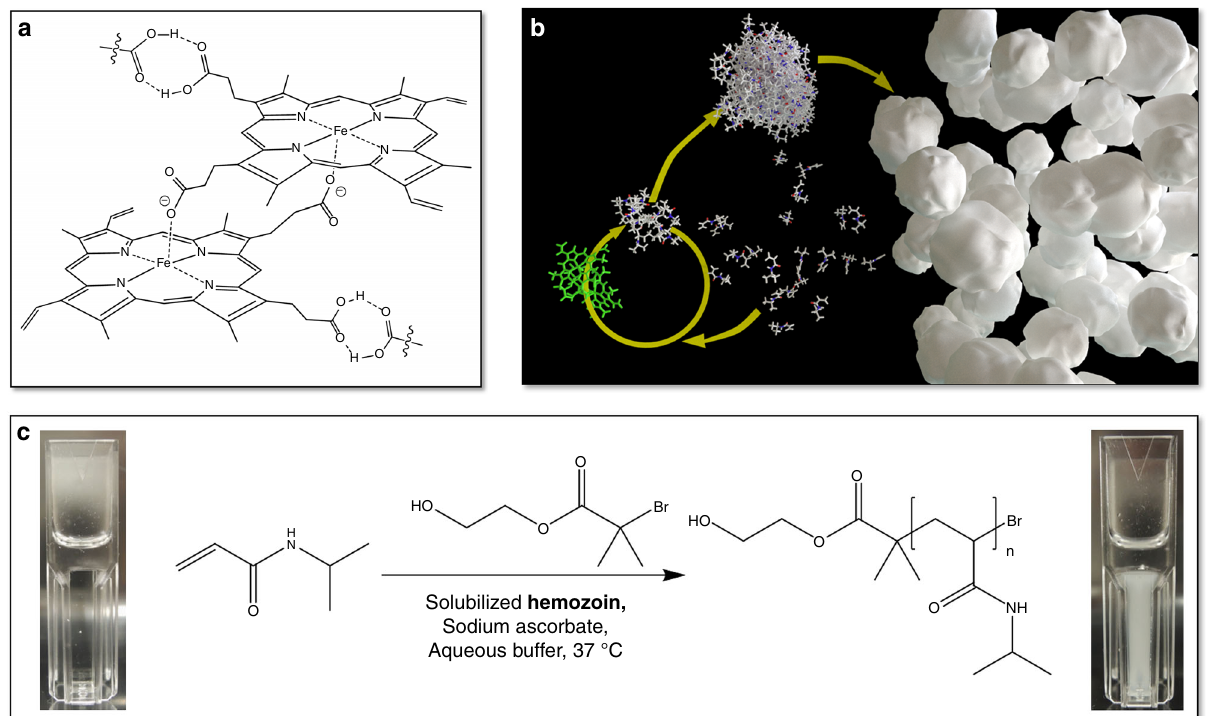
Fig. 1 Biocatalytic precipitation polymerization of NIPAAm as hemozoin assay. a Structure of Hz, a supramolecular crystal of dimers of hematin. b Schematic depiction of the Hz-catalyzed precipitation polymerization of NIPAAm. c Reaction scheme of the polymerization and photographs of a reaction mixture at the start of the reaction (left) and after 1 h (right) (1000 ng mL − 1